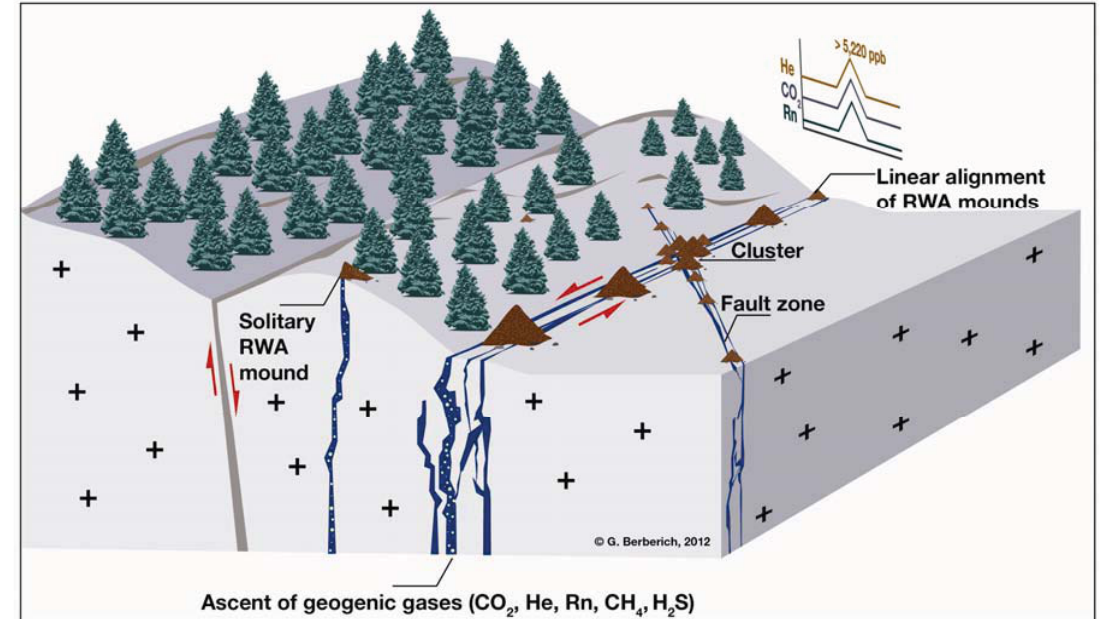
Figure 3. GeoBioScience: Relationship between RWA mound sites and gaspermeable tectonic fault systems showing gas anomalies: Along the open systems geogenic gas concentrations exceed atmospheric standards (He > 5,220 ppb) and background values (CO > 2 Vol%; Rn, CH and H S depending on the geological setting). Linear alignment 2 4 2 of RWA mounds occurs if the gaspermeable fault is running open for a very long distance, e.g., 3 km at the Oberehe site (West Eifel, cf. Figure 5(b)). At crosscut zones of tectonic fault systems clusters of RWA mounds occur. Solitary mounds can be found mostly at unusual locations with spotty degassing